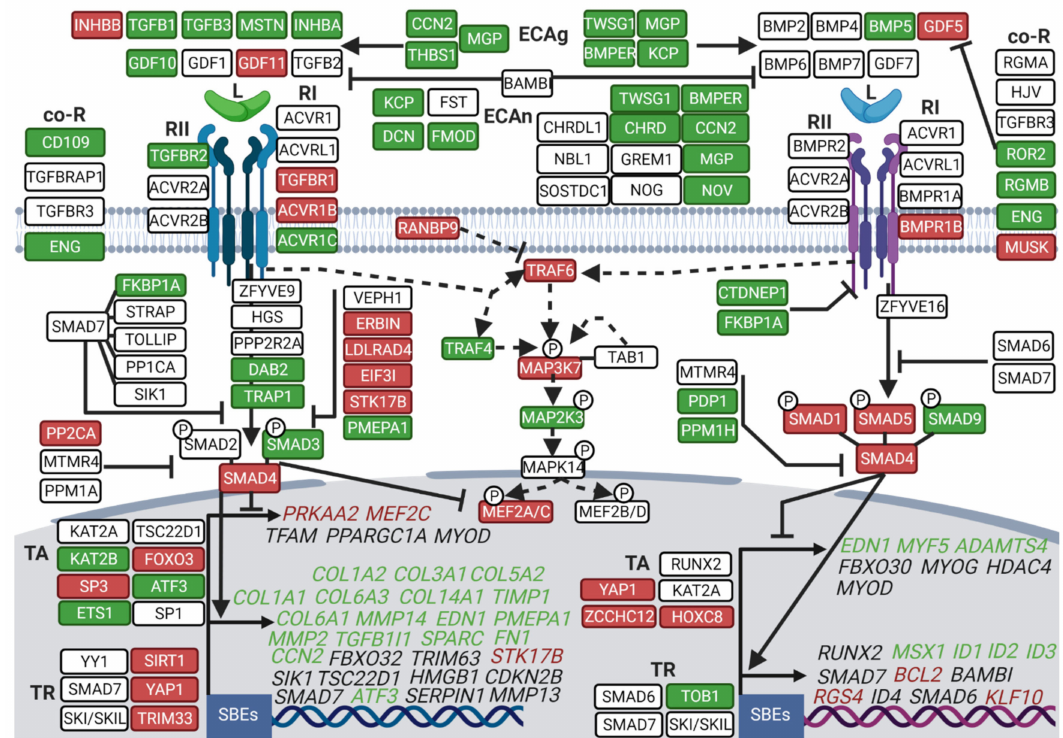
Figure 2. Deep transcriptomic reprogramming of TGF- β and BMP pathways in muscle during brown bear hibernation. Scheme showing brown bear vastus lateralis muscle transcripts involved in TGF- β and BMP signaling and depicting (i) their relationships [55–57] and (ii) the difference in their expression levels between hibernation and activity periods. Red and green boxes indicate, respectively up- and down-regulated genes during hibernation compared to the summer season, and white boxes indicate unchanged genes. Target genes of the TGF and BMP pathways are indicated in italic and are in green when down-regulated, in red when up-regulated, and in black when unchanged. Dashed lines show the SMAD-independent pathway and full lines the canonical signaling pathway. Arrows indicate activation, and ⊥ bars indicate inhibition. ( n = 6 bears/season, the same individuals were sampled and analyzed in summer and winter, padj < |0.05|; Tables S2 and S3). ECAg: Extracellular Agonist, ECAn: Extracellular Antagonist, L: Ligand, Co-R: Co-Receptor, RII: Receptor type II, RI: Receptor type I, TA: Transcriptional Activator, TR: Transcriptional Repressor, SBEs: SMAD Binding Element. Created with